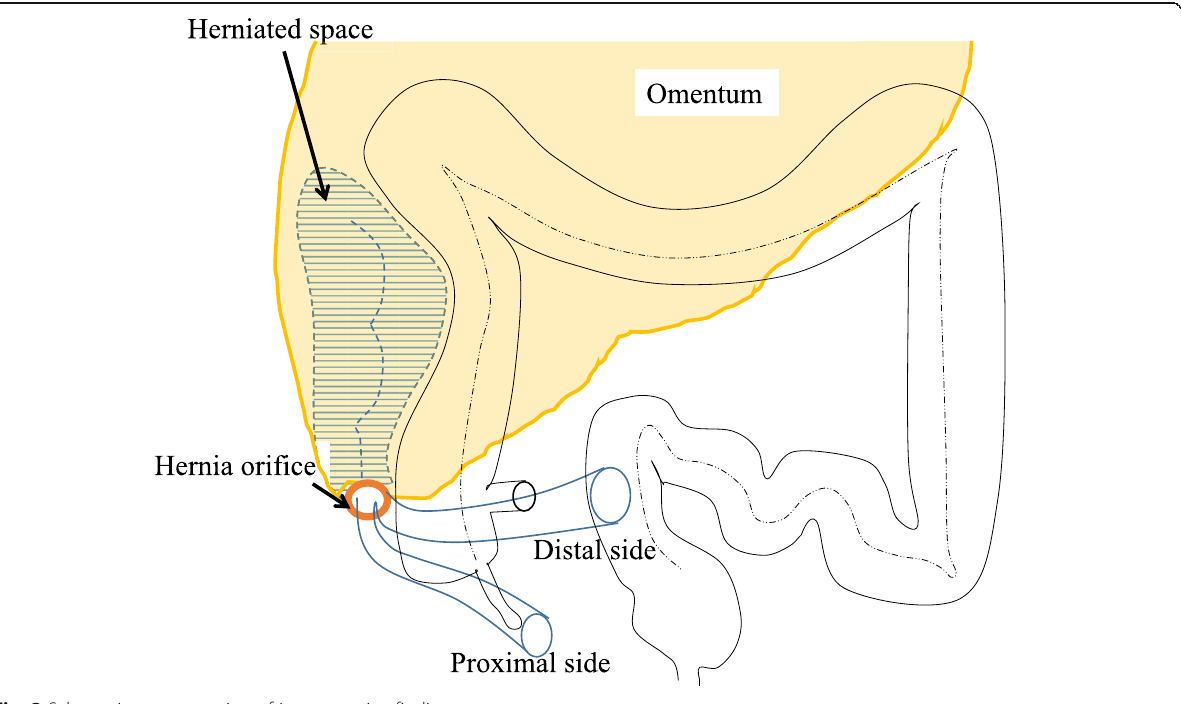
Fig. 3 Schematic representation of intraoperative